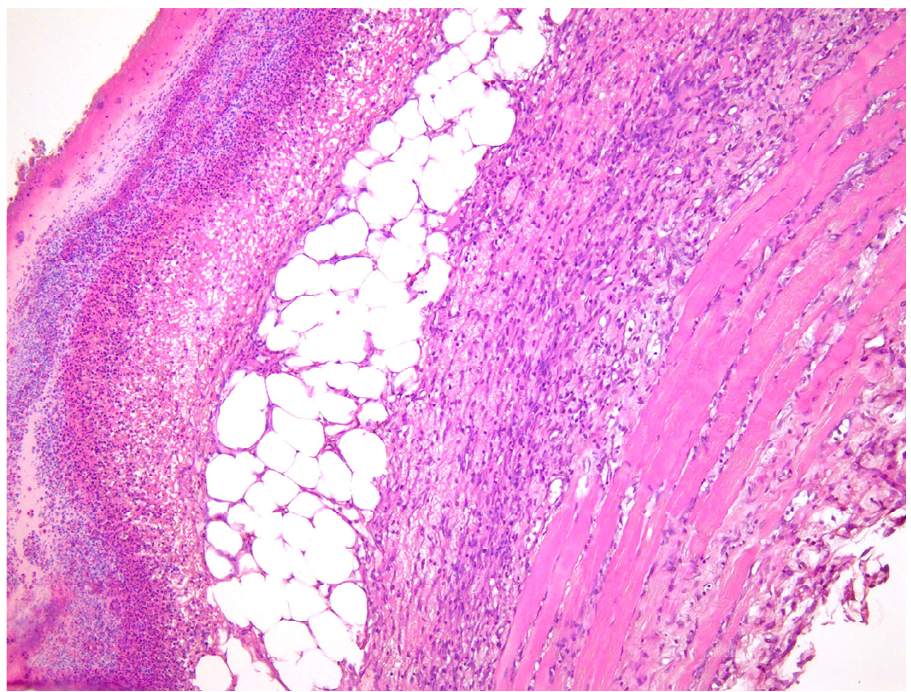
Figure A1. Histology of the wound treated with air at post ‐ operative day 4, hematoxylin and eosin staining, magnification—10×.